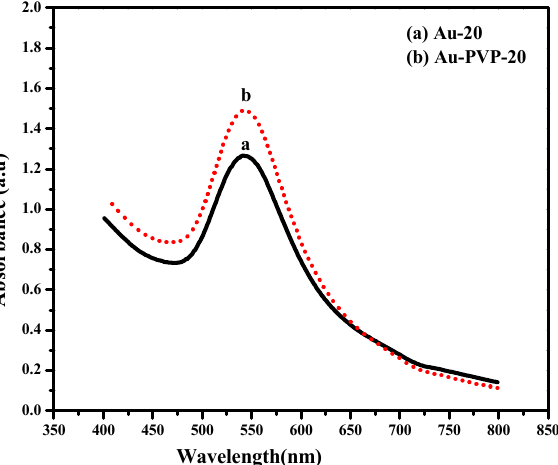
Figure 7. UV-VIS absorption spectra (a) Au-20 (solid line). (b) Au-PVP-20 (dotted line).